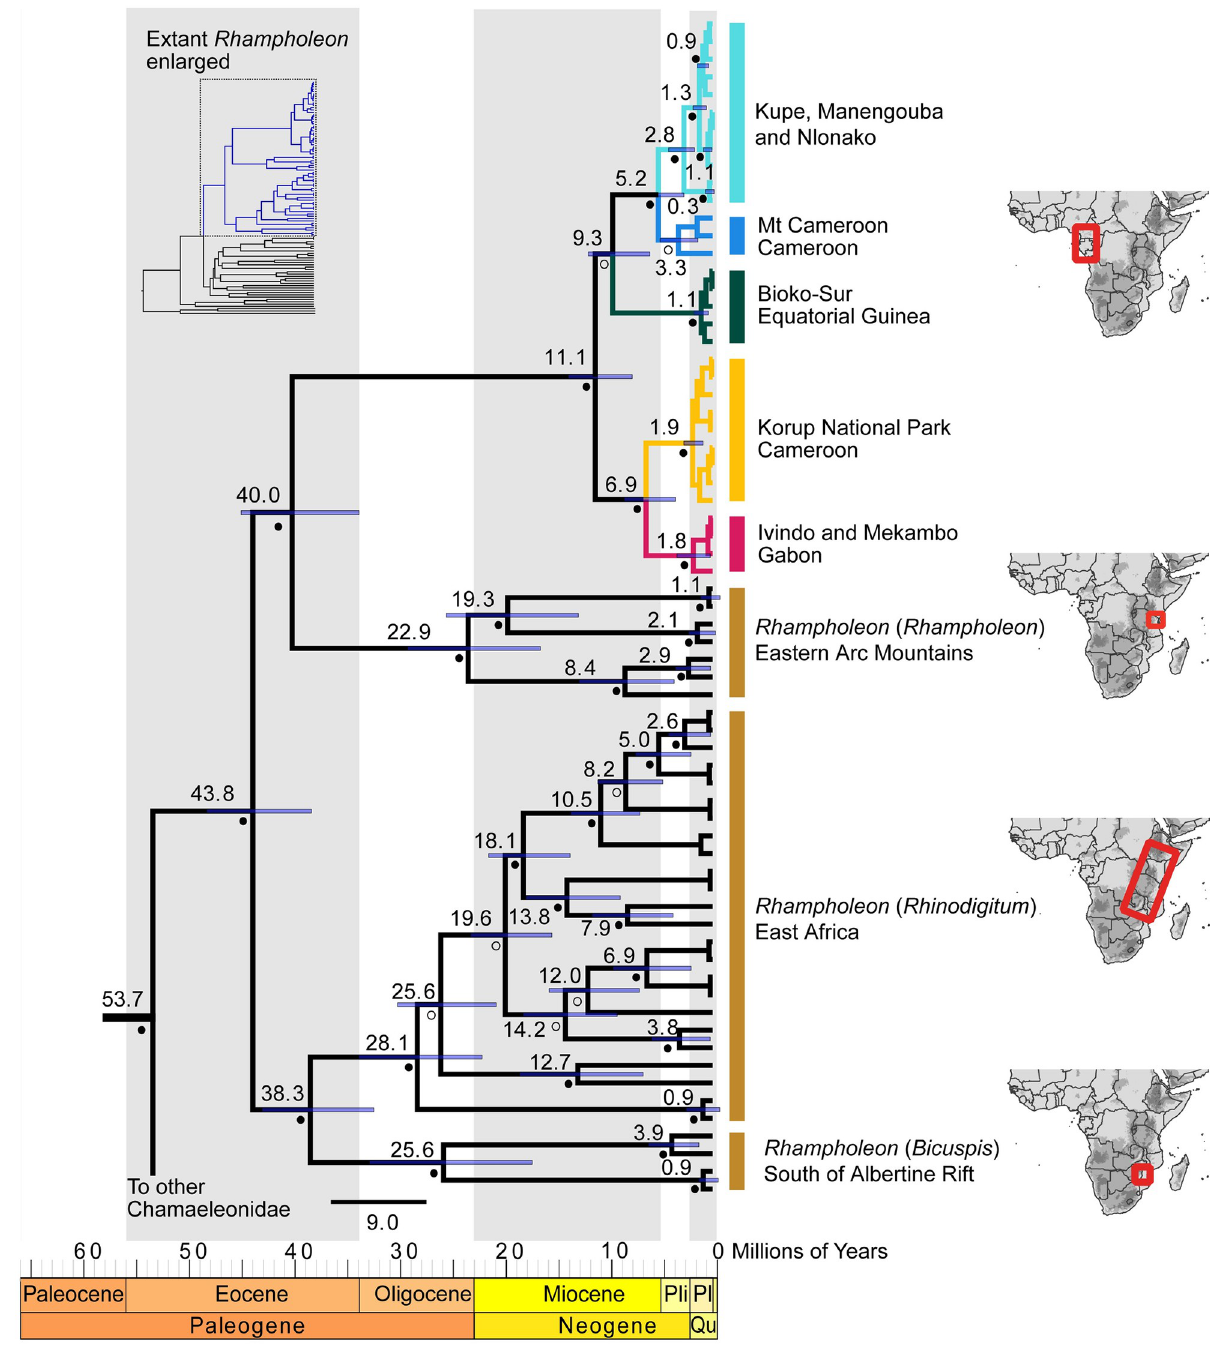
Fig 4. Bayesian chronogram of the Pygmy Chameleon genus Rhampholeon inferred from 16S + ND4 + RAG1 data. Nodes with high support ( � 95%) are denoted by filled circles adjacent to nodes and posterior probabilities ( < 95%) are denoted with empty circles. Median ages are provided above nodes and blue bars at nodes represent 95% highest probability densities (HPD). The spatial distribution of populations is presented with the same color scheme in Fig 2. Pli = Pliocene, Pl = Pleistocene, Qu = Quaternary.